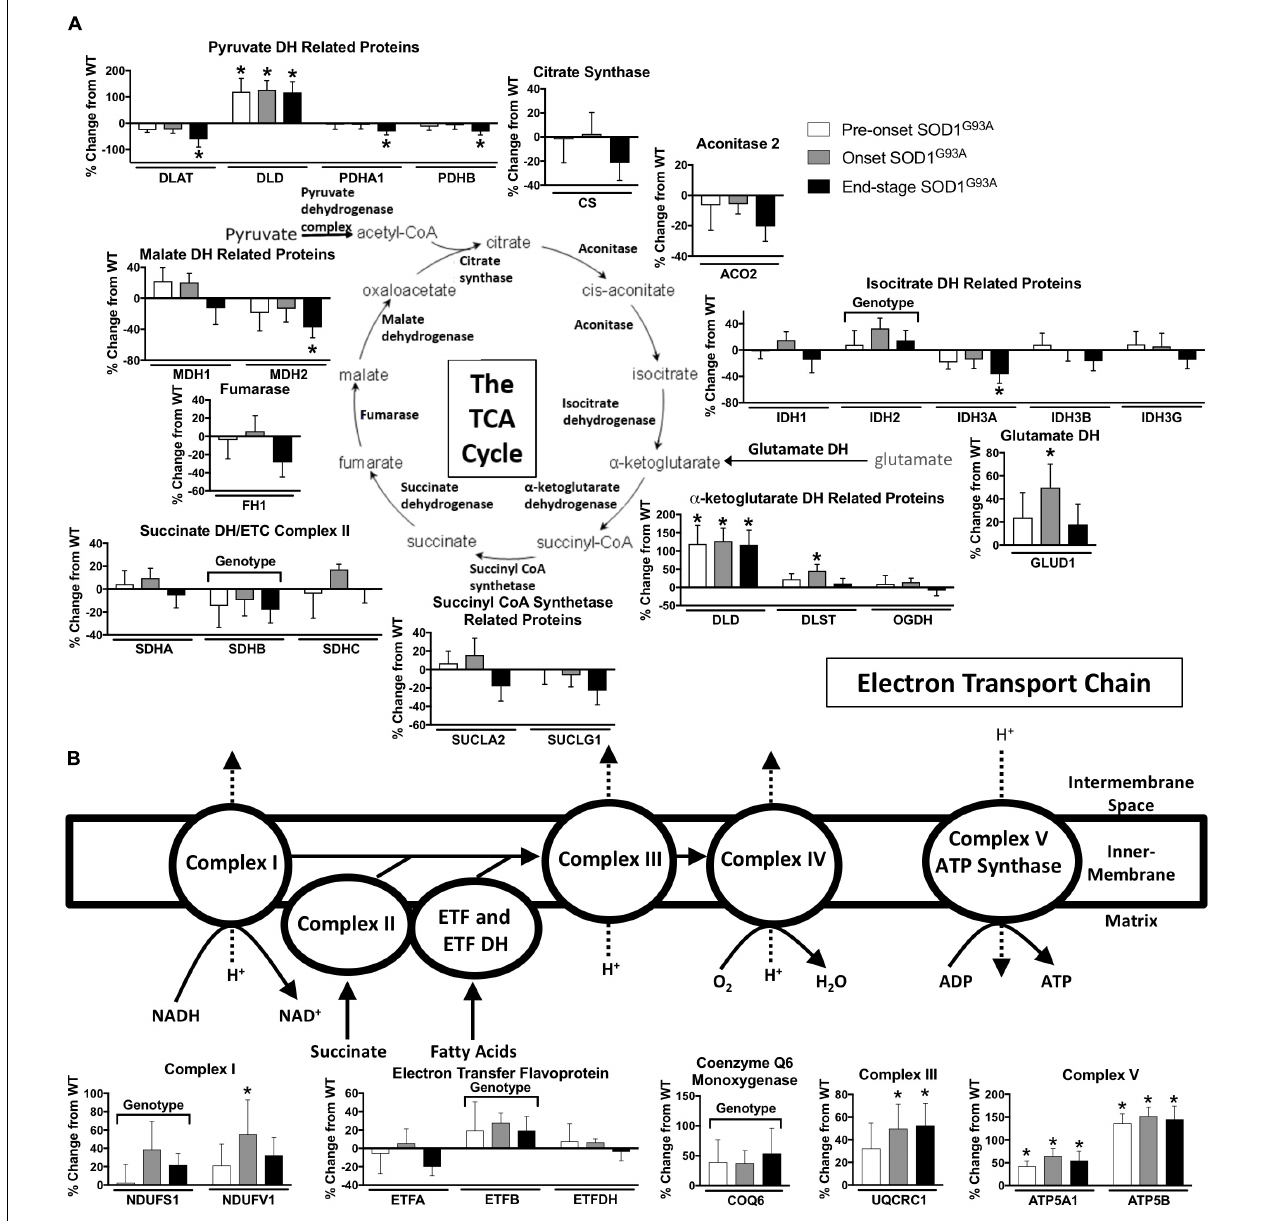
FIGURE 4 | Oxidative mitochondrial metabolism. Changes in protein content of oxidative mitochondrial metabolism in SOD1 G93A spinal cords compared to controls measured by mass spectrometry ( n = 5–6). (A) The tricarboxylic acid (TCA) cycle. (B) The electron transport chain (ETC). Data are represented as percent change relative to the same time point wild-type control. Bars represent means ± standard deviation. “Genotype” denotes a significant genotype effect in Benjamini-Hochberg corrected two-way ANOVA with p < 0.05 but no individual Multiple Comparison test was significant. Significance symbols demonstrate p < 0.05 for a genotype effect and additional significant results for the Tukey Multiple Comparison test. ∗ p < 0.05 wild-type vs. SOD1 G93A at the designated time point. SOD1 G93A pre-onset (white), SOD1 G93A onset (gray), SOD1 G93A end-stage (black). DH, dehydrogenase; CoA, coenzyme A; ETC, electron transport chain; ETF, electron transfer flavoprotein. Protein names, IDs, and absolute expression values are detailed in Supplemental Table 1